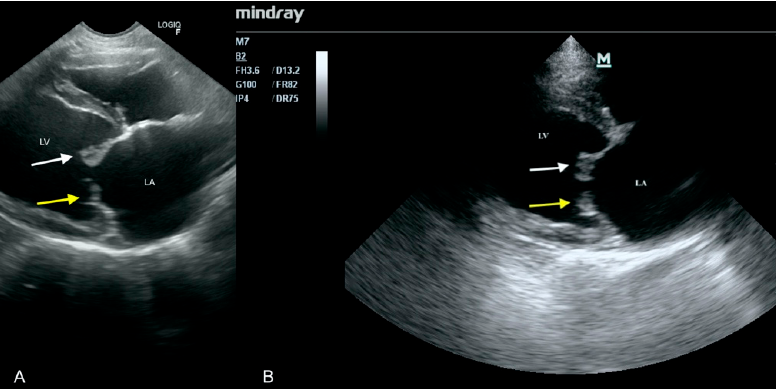
Figure 6. White arrow points to advanced vegetation on the anterior leaflet of mitral valve; yellow arrow points to advanced vegetation on the posterior leaflet of mitral valve. LA—left atrium, LV—left ventricle. ( A ) Scan from a microconvex probe obtained during focused cardiac ultrasound examina- tion (GE Healthcare Logiq F6). ( B ) Scan from phased array probe obtained during echocardiography examination performed by a board-certified echocardiography specialist(Mindray